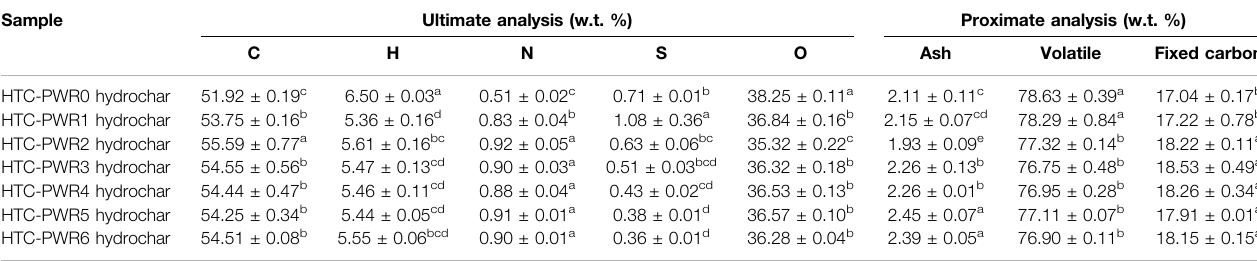
TABLE 2 | The ultimate and proximate analyses of wheat straw hydrochar after process water recirculation. Sample Ultimate analysis (w.t.